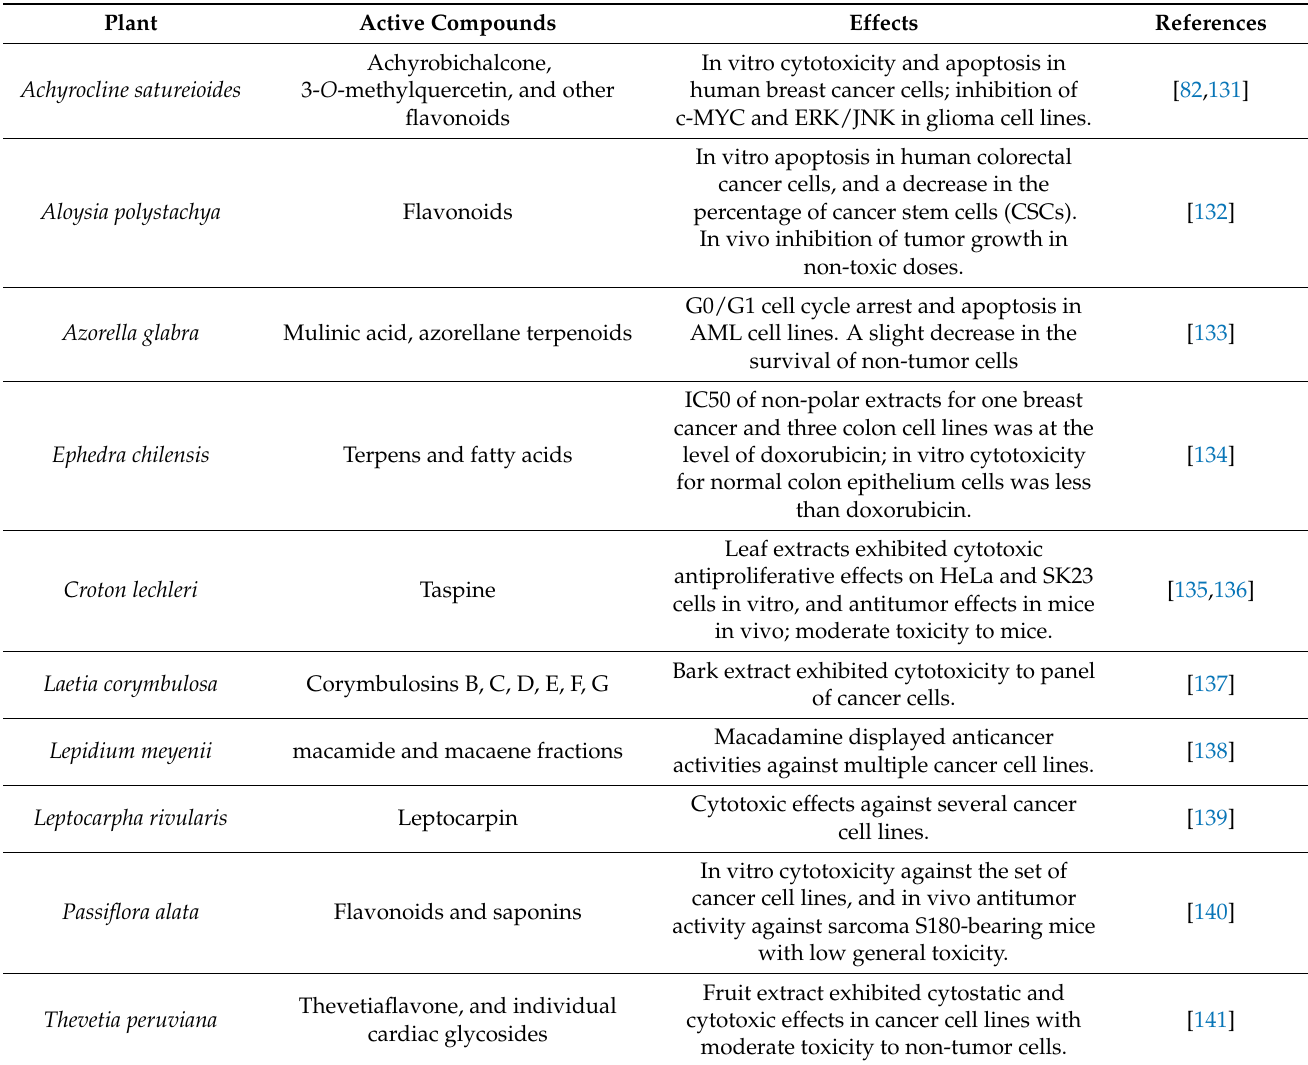
Table 2. Some South American plants and their compounds with anti-neoplastic